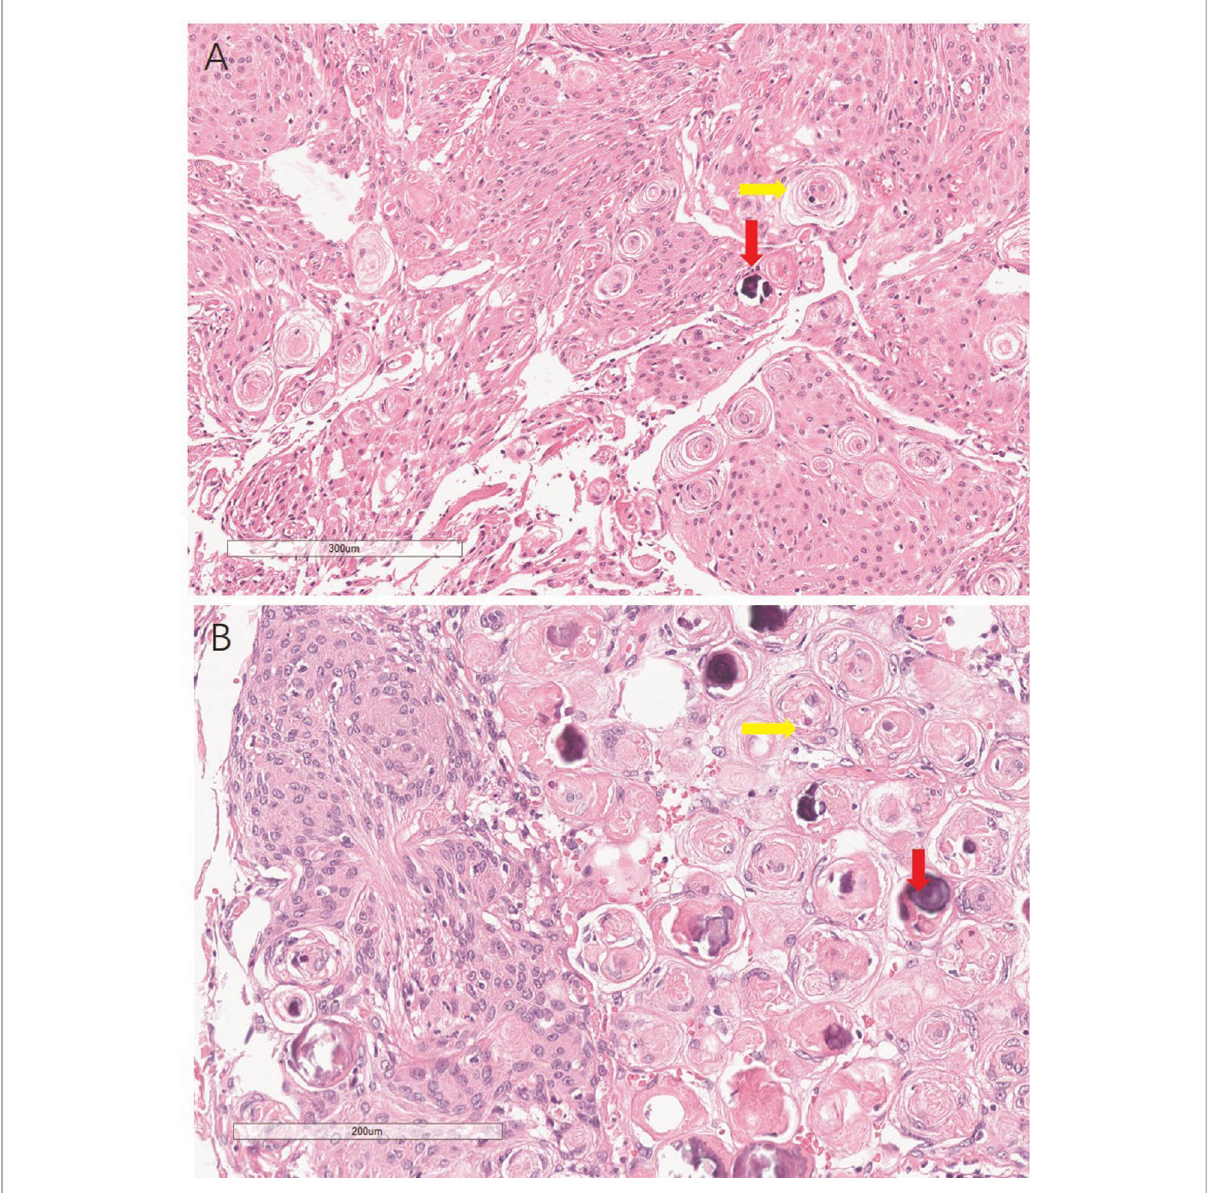
FIGURE 3 Histology of the meningiomas, showing psammoma bodies (yellow arrowhead) and calci fi cation (read arrowhead) in both falx and skull base